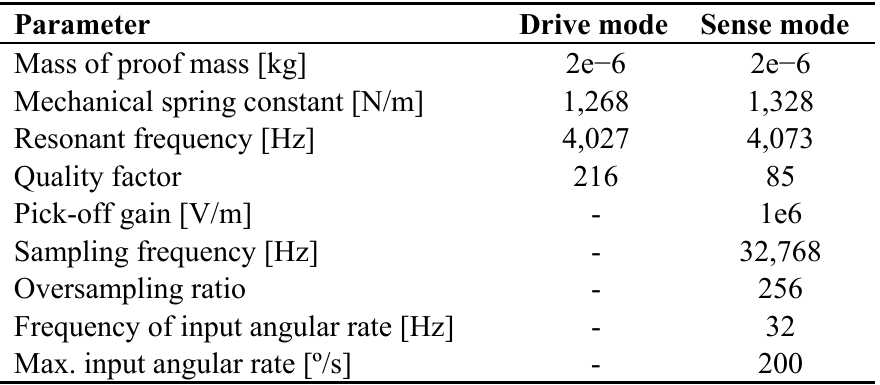
Table 5. Gyroscope and ΣΔ M Parameters.